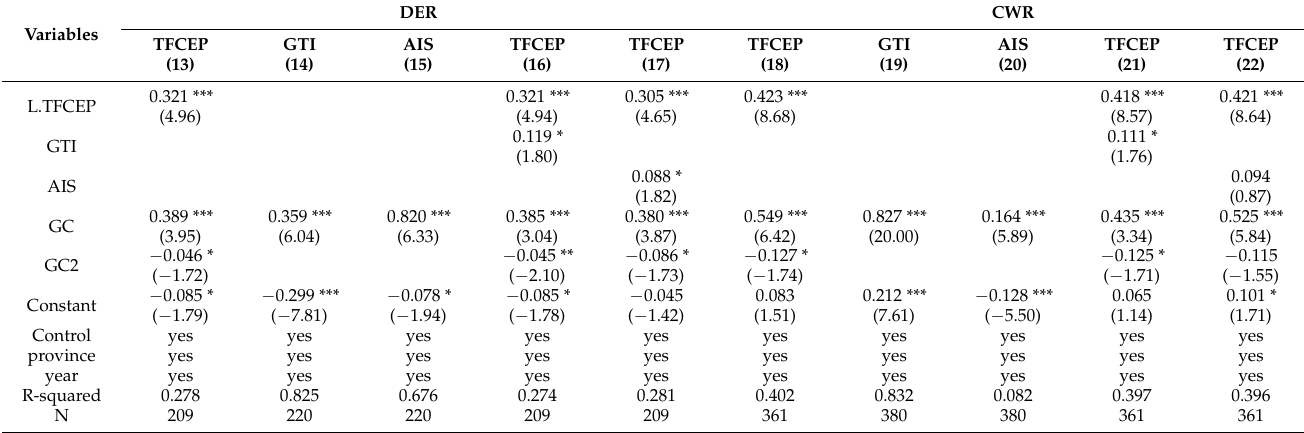
Table 7. Summary of regional heterogeneity